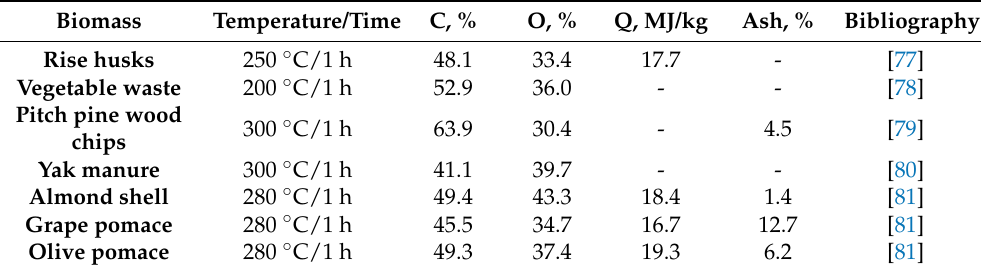
Table 2. The impact of torrefaction parameters on the content of the main elements, the value of the heat of combustion Q, and the ash